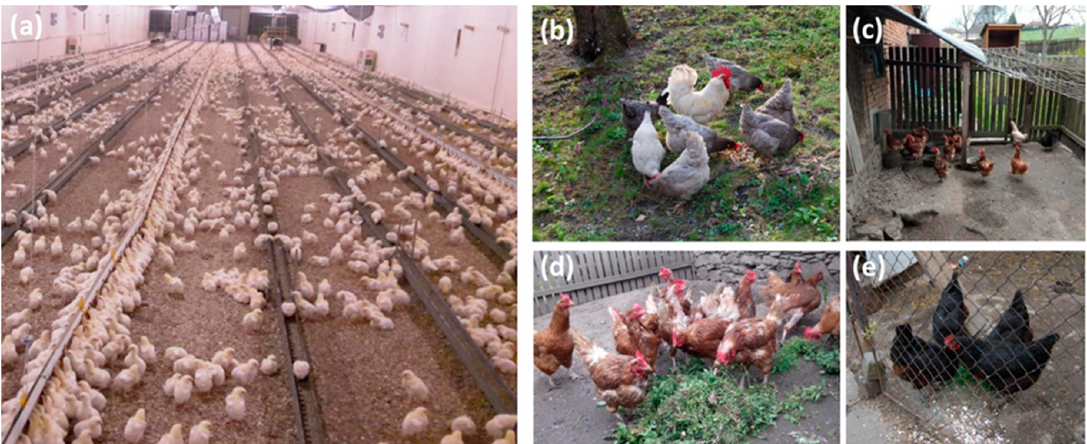
Figure 1. Living environment of indoor and outdoor chickens. Raising of egg layers in commercial production in an indoor environment (panel ( a )) and egg laying hens in an outdoor, backyard environment (panels ( b – e